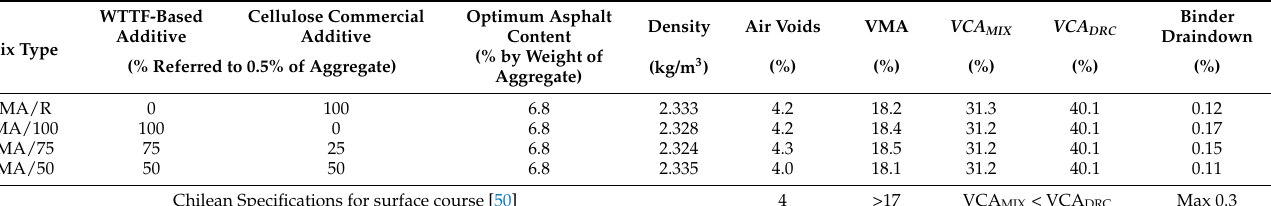
Table 5. Design parameters of the mixes